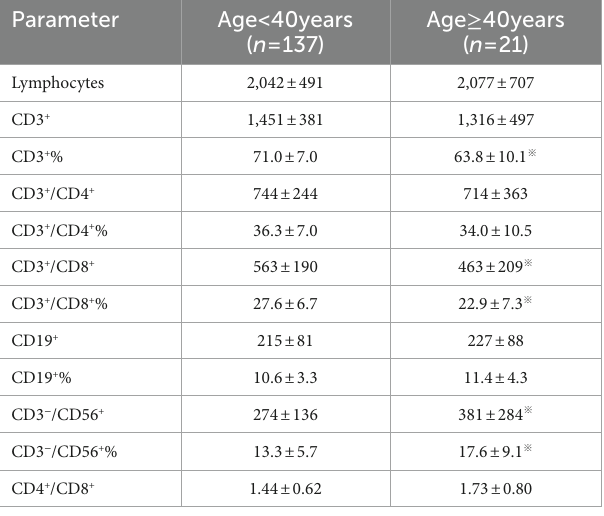
TABLE 4 Absolute values and percentages of lymphocyte subpopulations in Experiment group by age group (Mean ± SD, cells/ μ L).